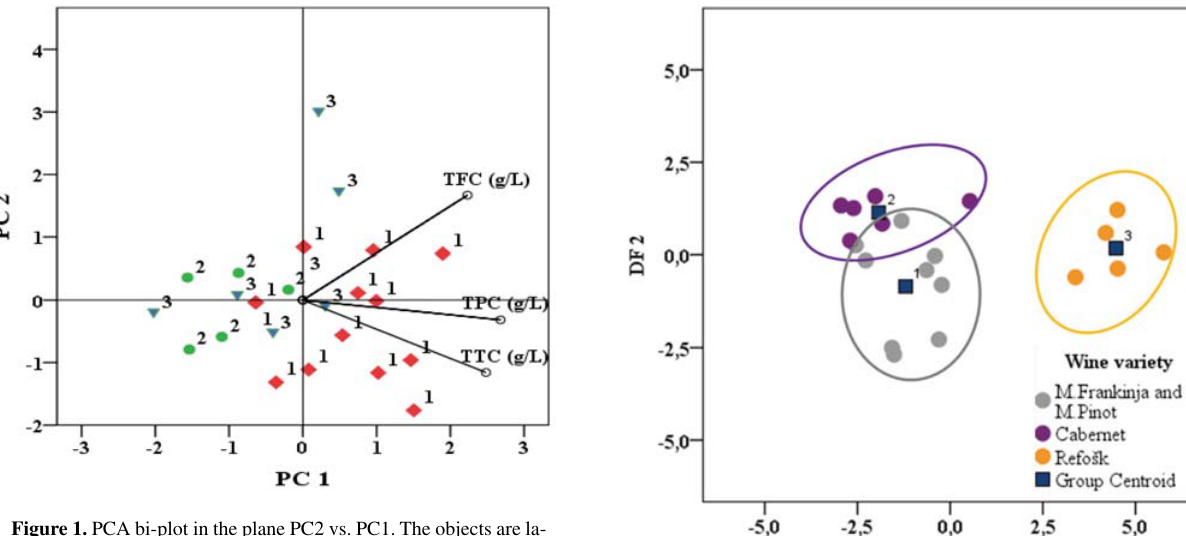
Figure 1. PCA bi-plot in the plane PC2 vs. PC1. The objects are la- belled by Slovenian wine growing regions. The first principal com- ponent (PC1) explained 78% of the variation between the samples, and the second (PC2) explained 18% of the variation. PC1 and PC2 values separate samples according to TPC and TFC, respectively ( (cid:2) Primorska wine growing region; (cid:2) Podravje wine growing re- gion and (cid:2) Posavje wine growing region)